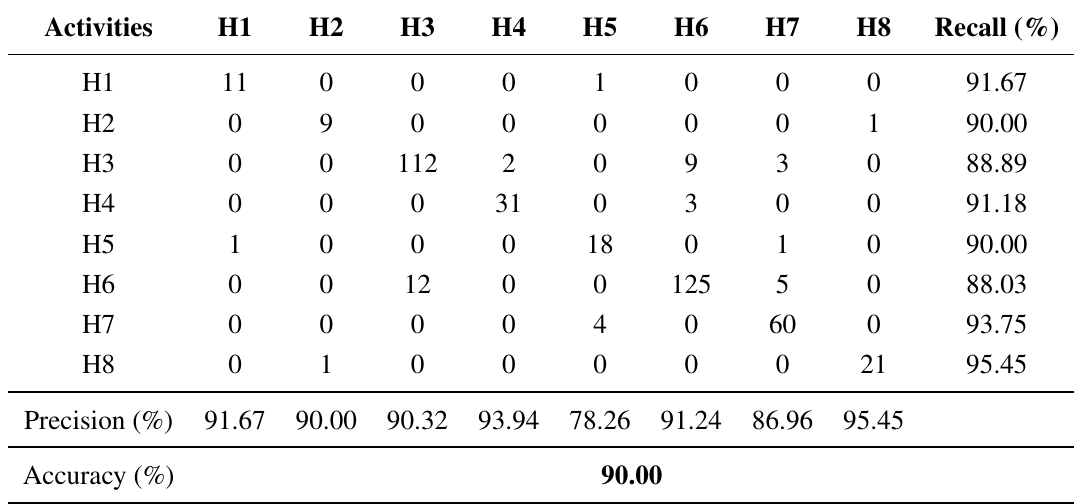
Table 6. Confusion matrix of the SVM classifier using PAM for the horizontal traffic. Activities